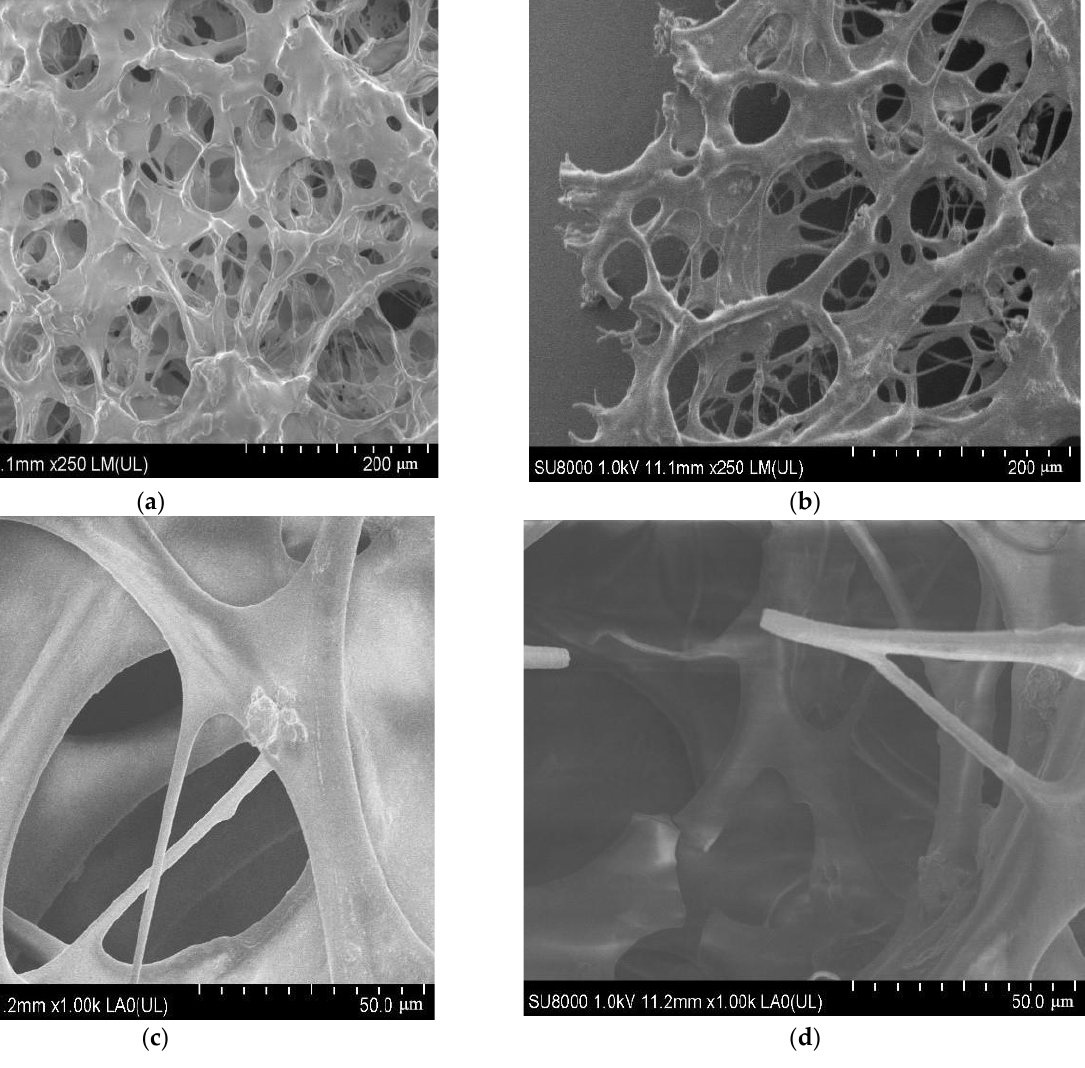
Figure 8. SEM images for the xxx. ( a ) gel structure after aging at 130 °C; ( b ) gel structure after aging at 150 °C; ( c ) gel structure after aging at 130 °C; ( d ) gel structure after aging at 150 °C.